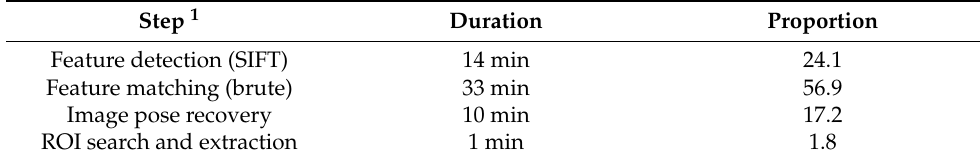
Table 1. Time cost for extracting ROIs in the case